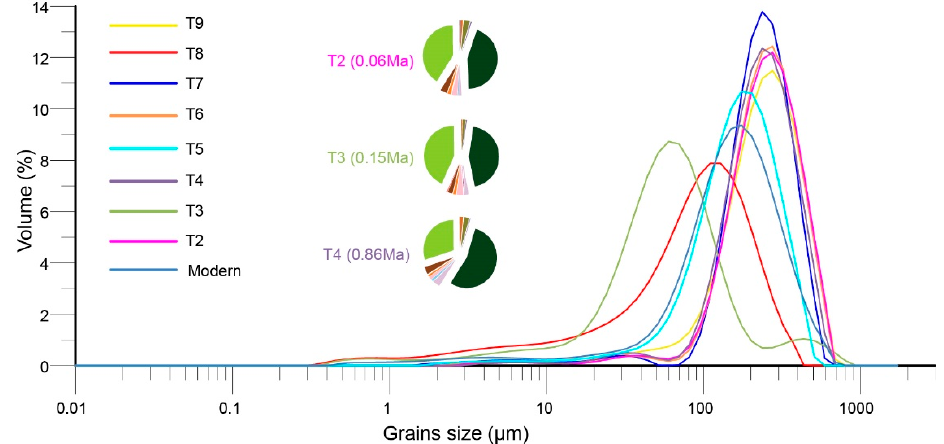
Figure 5. Grain-size curves of sediment samples from Yellow River terraces of the Lanzhou area, and heavy-mineral spectra for terraces T2, T3, and T4. Mineral color-code as in Figure 2.